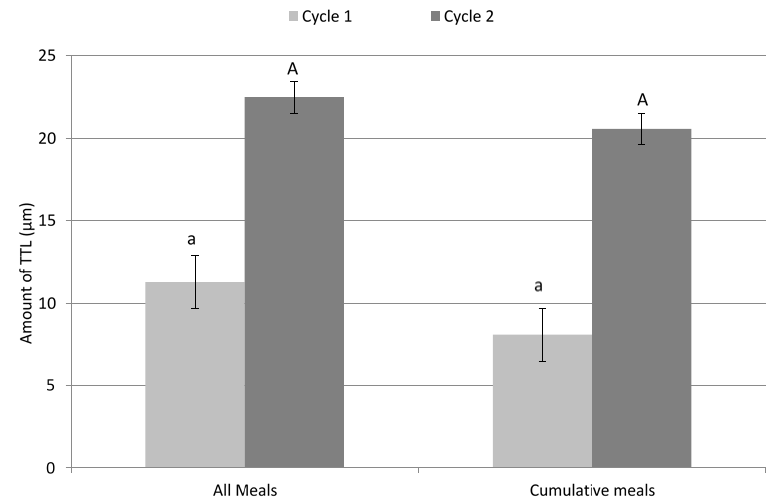
Figure 1. The total amount of tooth tissue loss (TTL) caused by a sequence of meals compared to the sum of individual meals following one and two cycles. Error bars show standard deviation and the use of different letters signifies that groups are significantly different ( p < 0.05). Lower case letters are associated with cycle 1 and upper case letter are associated with cycle 2. Dent. J. 2016 , 4 , x FOR PEER